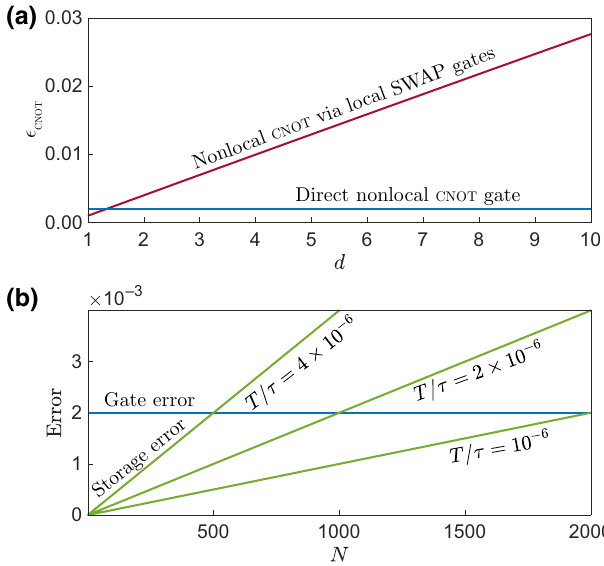
FIG. 5. With nearest-neighbor Rydberg gate errors of (cid:10) R = 10 − 3 [62], the nonlocal teleported CNOT gate error is limited to ∼ 2 (cid:10) = 2 × 10 − 3 (a) Error probabilities due to local two- (cid:10) R CNOT qubit gate errors for gates between qubits d sites apart, when , solid implemented directly via teleportation (constant error (cid:10) CNOT blue) or via local SWAP gates [red, three local CNOT gates per SWAP gate for an error (cid:10) R + 3 ( d − 1 )(cid:10) R ]. (b) Comparing storage and gate errors for implementing serial any-to-any gates. The before storage serial system can be scaled until NT /τ ∼ (cid:10) CNOT errors would dominate gate